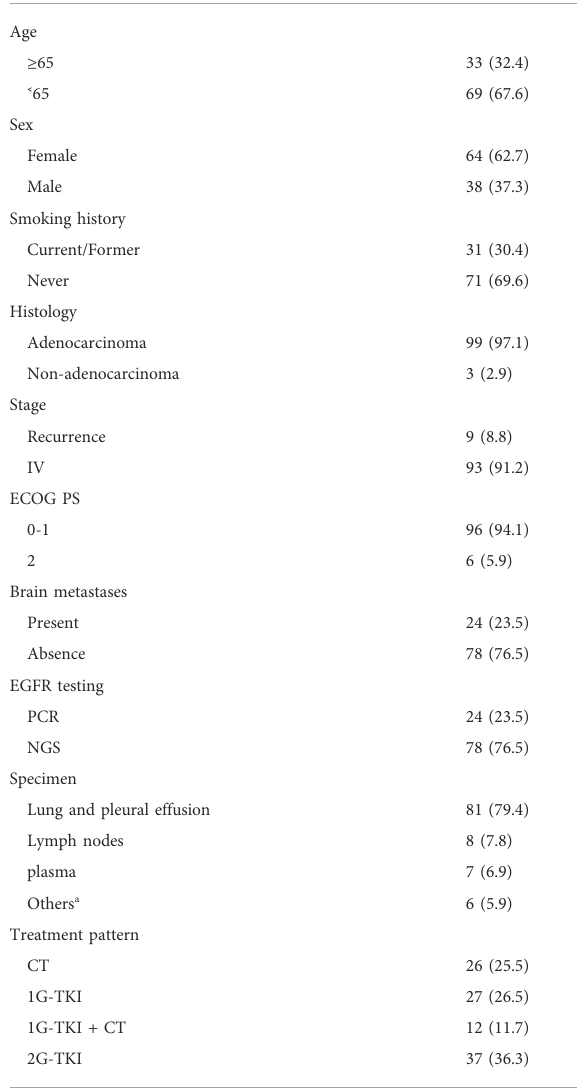
TABLE 1 Clinicopathological characteristics of NSCLC patients with EGFR uncommon